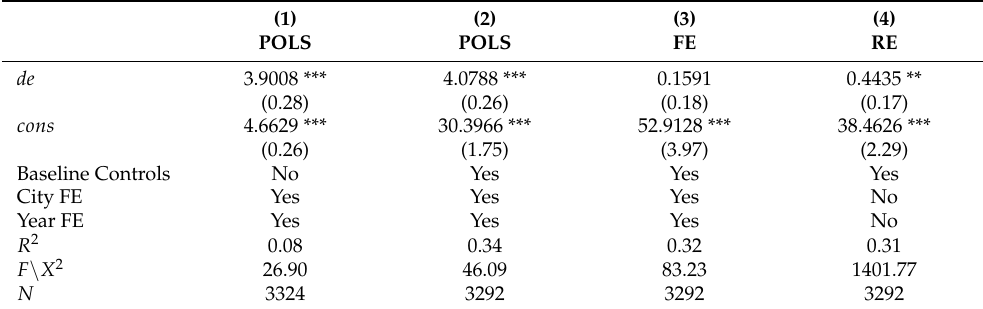
Table 6. Differences in CO 2 emissions between excessive and insufficient groups.